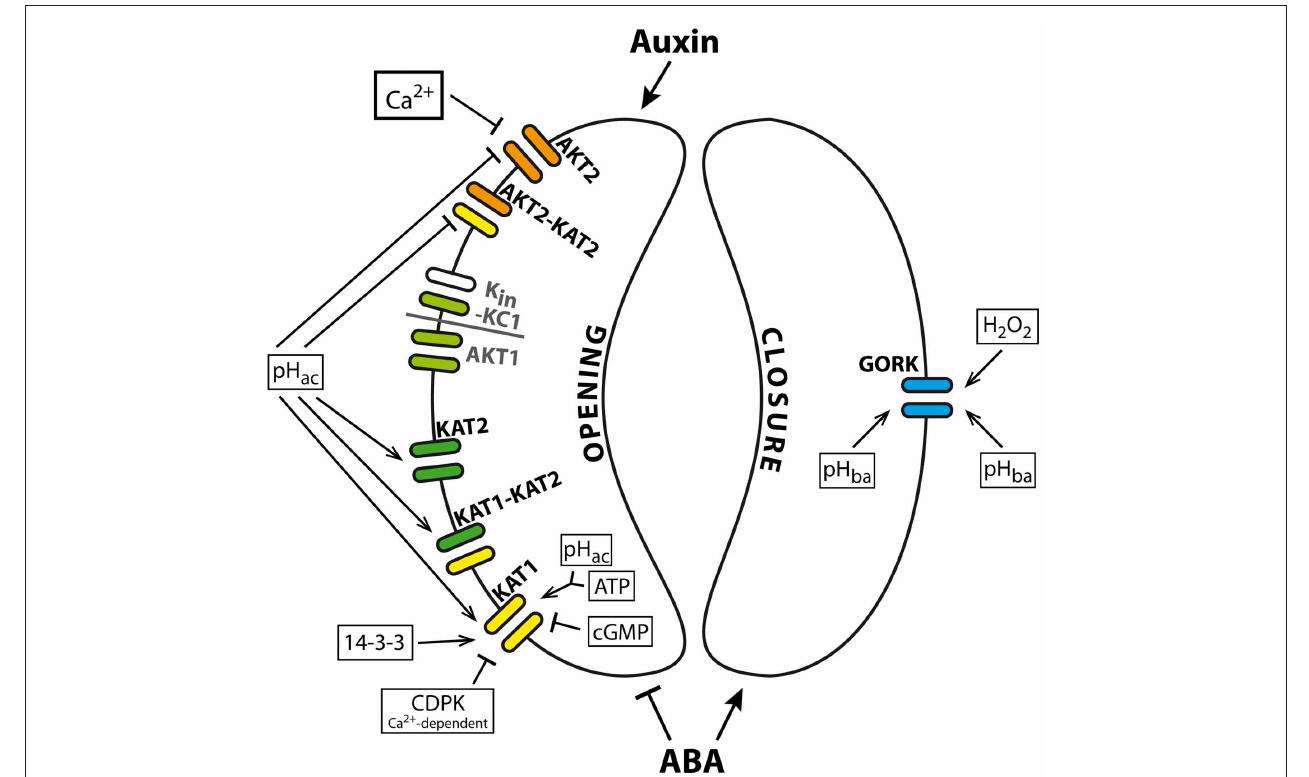
FIGURE 3 | K + channels in Arabidopsis guard cells and their effectors. Changes in membrane potential lead to stomatal opening or closure, respectively. Membrane hyperpolarisation in response to H + -ATPase activity activates inward-rectifying K + channels. Transcripts for KAT1, KAT2, AKT1, AKT2, and AtKC1 are detectable in guard cells (Szyroki et al., 2001). All these K + channel subunits form heterotetrameric channels like KAT1-KAT2, AKT2-KAT2, and AKT1-AtKC1. The impact of AKT1 and K in -AtKC1 on stomatal movement has not been investigated in detail. Acidification affects directly the currents through K + channels in guard cells. K in channels are activated upon